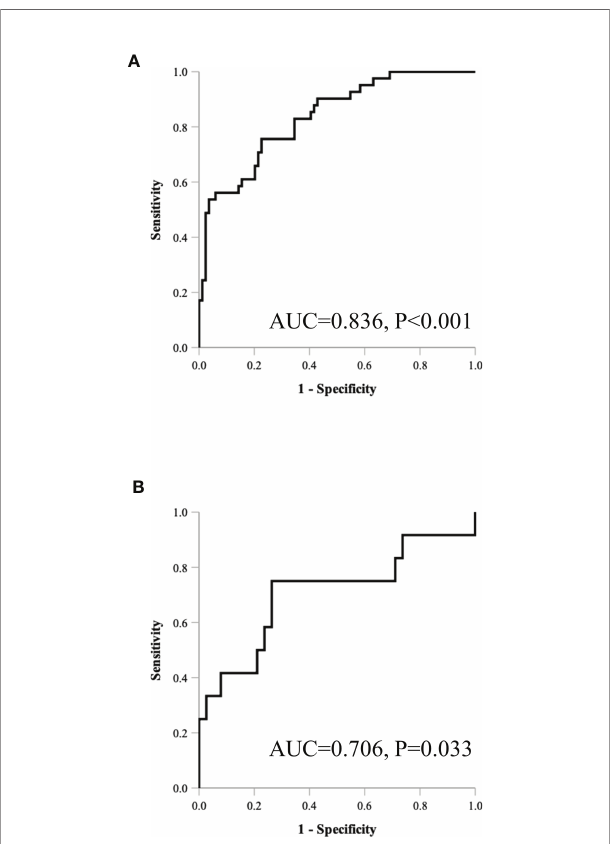
FIGURE 4 | ROC results of the fi nal model of the training set (A) and validation set (B) .